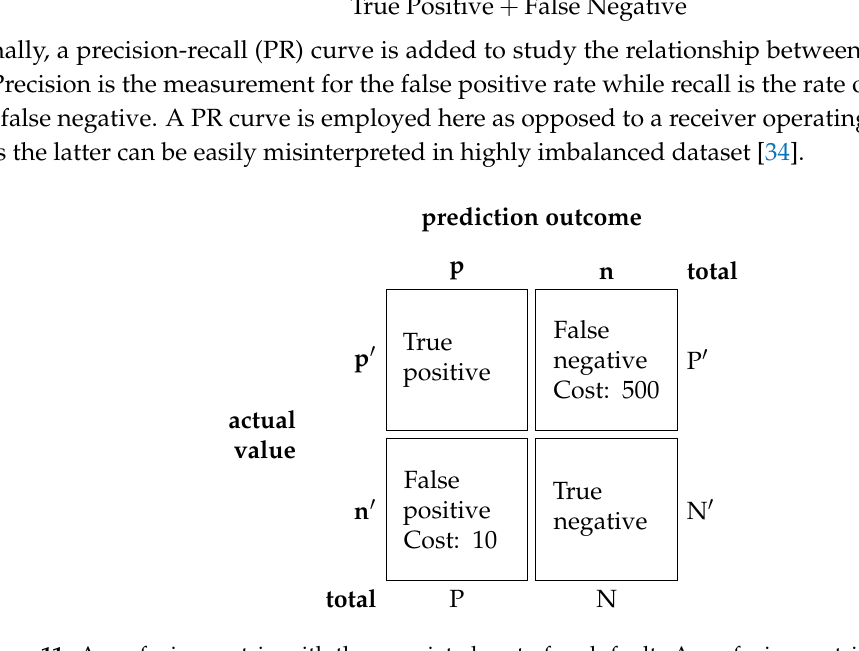
Figure 11. A confusion matrix with the associated cost of each fault. A confusion matrix tabulates the performance of a classification model. A true positive and true negative are correct classification therefore, there are no cost associated to it. Whereas false positive and false negative receive a cost of 10 and 500 respectively. The p and n represents positive and negative class while P and N represents the total positive and negative class. The actual class is denoted by an apostrophe, (cid:48)